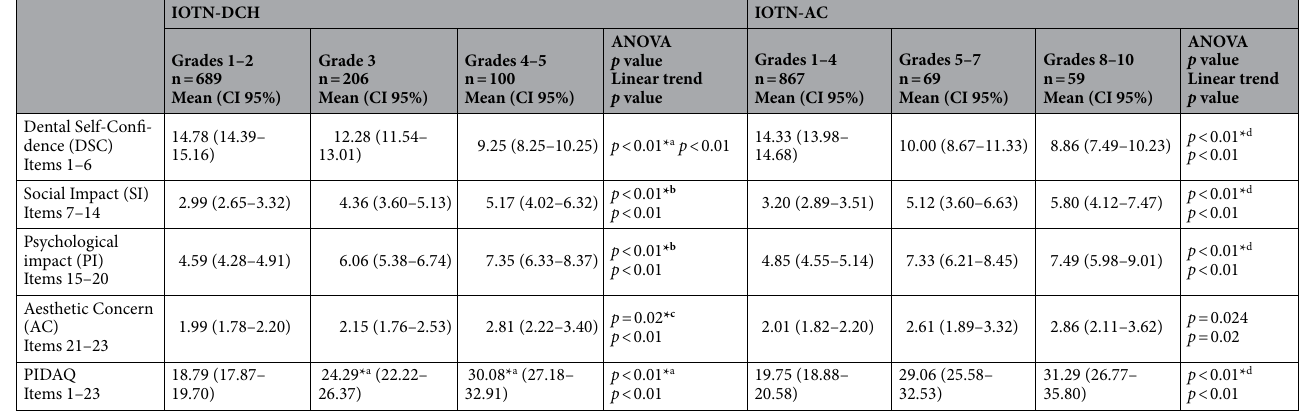
Table 3. PIDAQ means for each grade of treatment need according to IOTN-DHC (CI 95%), IOTN-AC (CI 95%) and ANOVA contrasts of means. * p value < 0.05. Post Hoc Bonferroni. Statistical significance between groups: a 1 versus 2, 3 and 4; 2 versus 3 and 4; 3 versus 4, b 1 versus 2 and 3, c 1 versus 3, d 1 versus 2 and